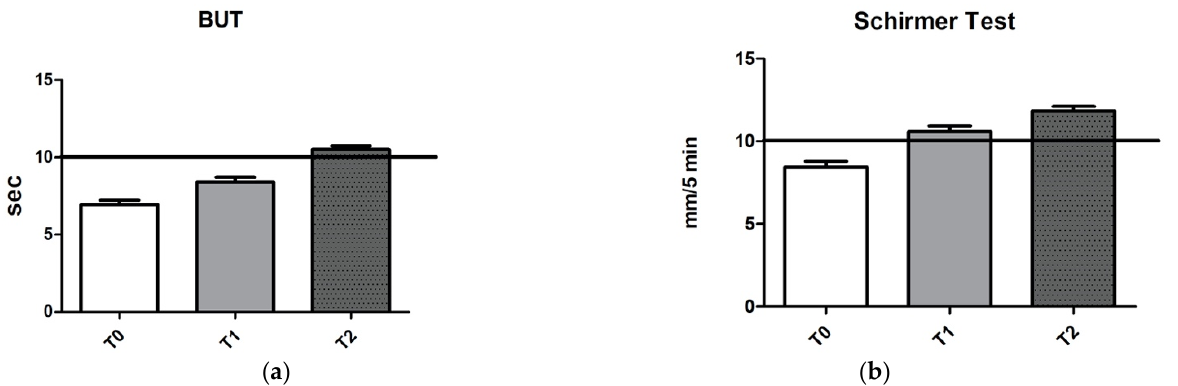
Figure 2. Improvement of tear function over time recorded by both ( a ) TBUT and ( b ) Schirmer’s test. Black horizontal lines represent the boundary between normal (above) and pathological (below) values (ANOVA p < 0.0001).